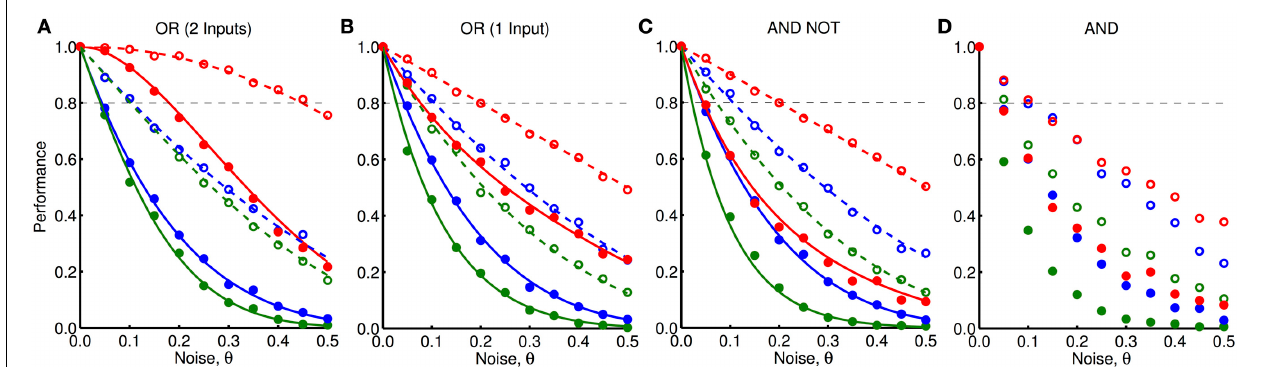
FIGURE 9 | Robustness to noisy oscillations. (A) Performance, given by the fraction of trials in which the output unit was activated, of the “OR” network shown in Figure 3 (with both inputs active) to different amounts and types of noise, θ . These different types are: noise only for feedback inputs (blue), noise only for feedforward inputs (red), and noise for both feedforward and feedback inputs (green). The noise can be either “simple noise” (solid) or